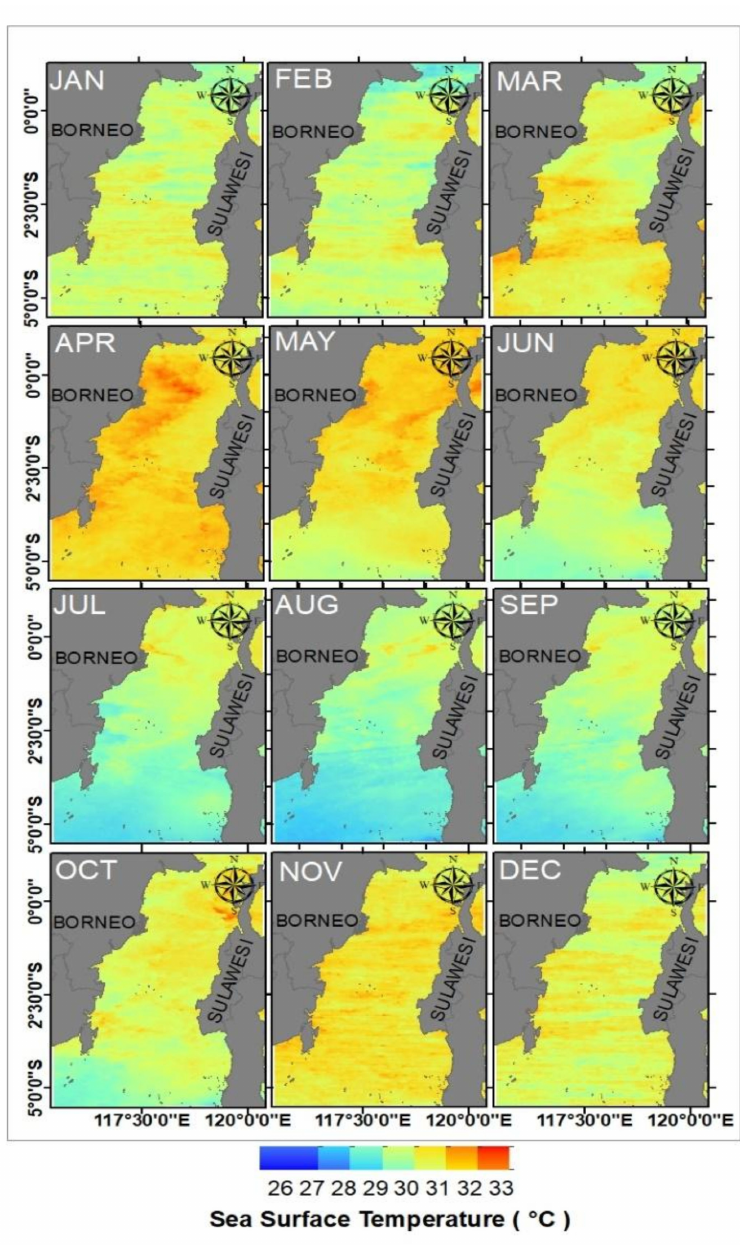
Figure 2. The Spatial Distribution Map of Average Sea Surface Temperature 2015–2020 in the Makassar